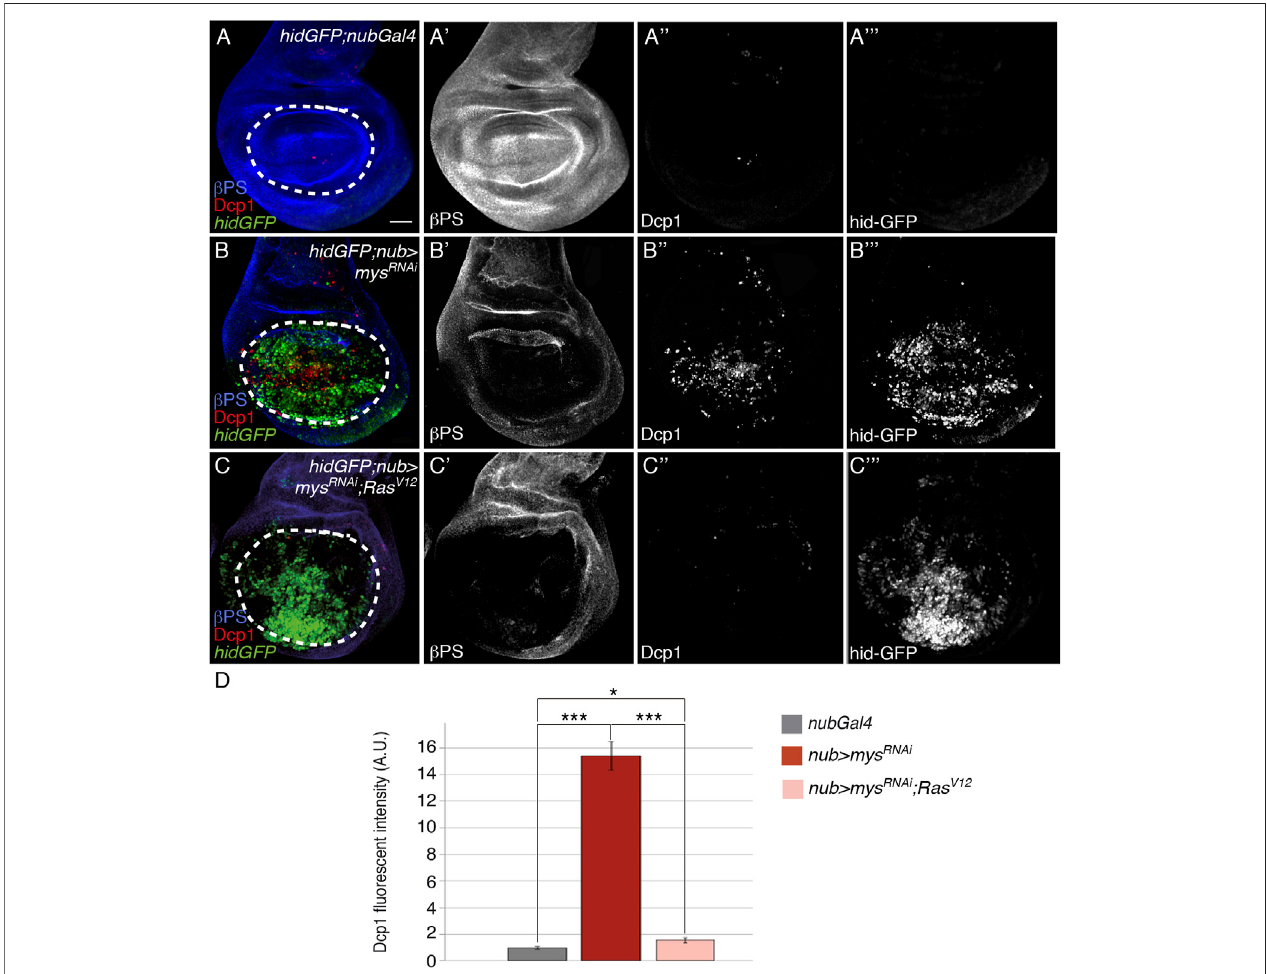
FIGURE 6 | Ectopic activation of the Ras pathway rescues anoikis. (A – C ’’’ ) Maximal projection of confocal views of third-instar wing imaginal discs carrying the reporter hidGFP , stained with anti- β PS [blue in (A – C) , white in (A 9 – C 9 )] , anti-Dcp1 [red in (A – C) , white in (A ’’– C ’’ )] and anti-GFP [green in (A – C) , white in (A - – C - )] . (A – A - ) Control hidGFP;nubGal4 wingdisc. (B – B - ) hidGFP wingdiscexpressinga mys RNAiunderthecontrolof nubGal4 , hidGFP ; nub > mys RNAi . (C – C - ) hidGFP wing disc co-expressing a mys RNAi and an activated form of Ras, Ras V12 , under the control of nubGal4 hidGFP ; nub > mys RNAi ; Ras V12 . (D) Quanti fi cation of Dcp1 levels in wing discs of the indicated genotypes. The statistical signi fi cance of differences was assessed with a t -test, *** and * p values < 0.001 and < 0.05, respectively. Scale bar in all panels, 30 μ m.